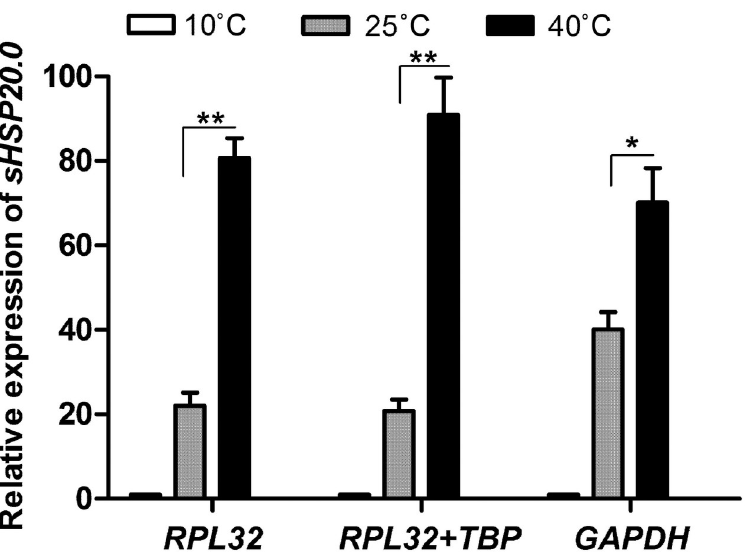
Fig 4. The relative expression of target sHSP20 . 0 normalized by the recommended set of references ( RPL32 and TBP ), the optimal reference ( RPL32 ) and the least stable gene ( GAPDH ), respectively. Columns represent the expressions of sHSP20 . 0 in Phaedon brassicae when subjected to cold shock (10˚C), heat shock (40˚C) and the control (25˚C) for 2 h. Error bars indicate SE; � , P < 0.05; �� , P < 0.01 (Student’s t -test by SAS 9.20).